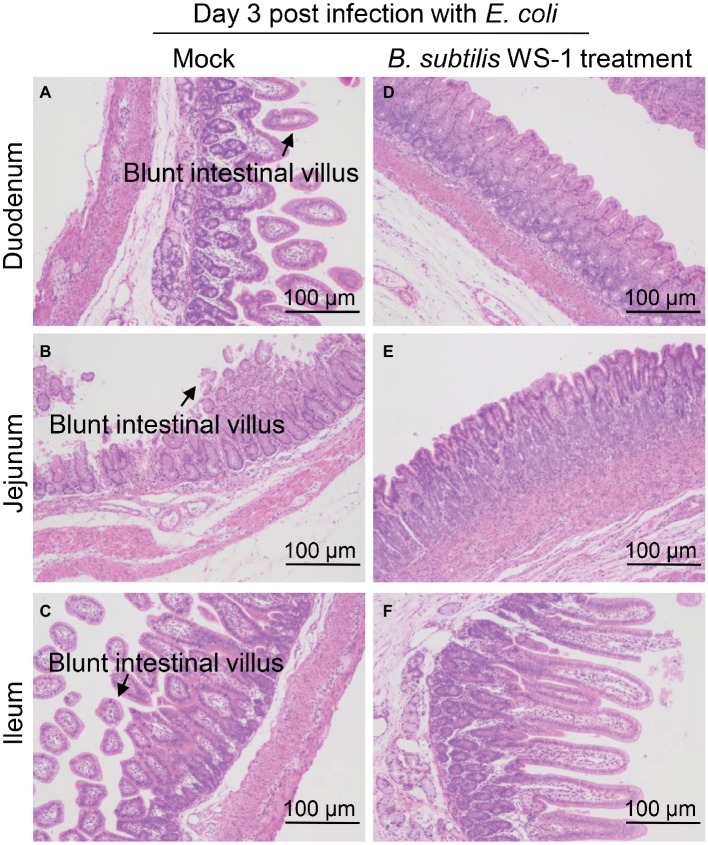
Intestinal changes in newborn piglets post-challenge with E. coli of the control group and the B. subtilis strain WS-1 treatment group. (A–C) Hematoxylin and eosin (H&E)-stained intestinal tissue section (blunt intestinal villus was indicated by arrows) of a control piglet at 3 d.p.c. (D–F) H&E-stained intestinal tissue section of a B. subtilis strain WS-1 treatment piglet at 3 d.p.c. The data are representative of two independent experiments. Data are represented as mean ± SD, n = 1 or n = 2.